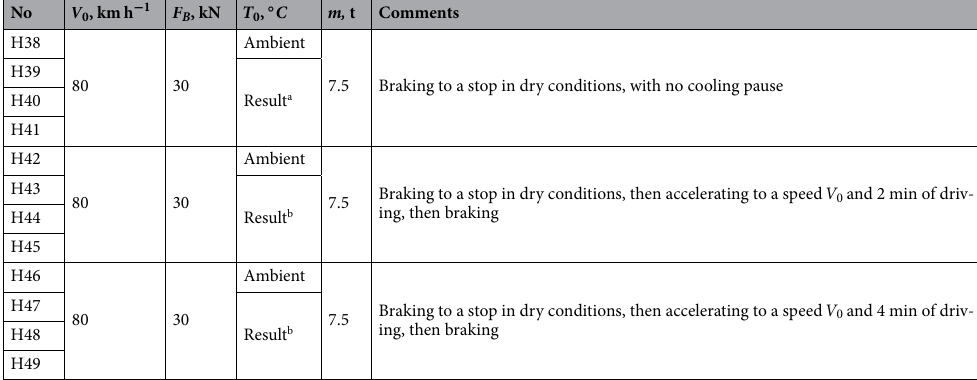
Table 2. Test program on a full-scale inertia dynamometer. a The initial temperature is equal to the temperature that is reached after the end of the preceding braking and the direct acceleration of the wheel to V 0 . b The initial temperature is equal to the temperature that is reached after the end of cooling phase (after the preceding braking and the direct acceleration of the wheel to V 0 ).